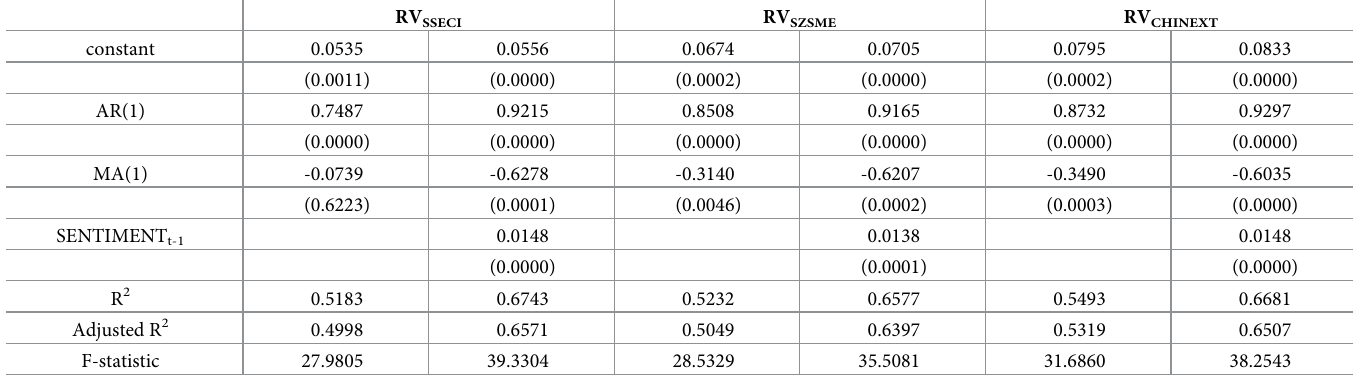
the prediction performance. RMSE refers to the prediction errors. Theil’s inequality coefficient provides a measure of how well the predicted values compares to the observed values. The smaller the RMSE and Theil’s inequality coefficient are, the better the model performs. As shown in Table 9, investor sentiment which is constructed with INR, SMT, TURN and SVI (noted as SENTIMENT in Table 9) helps ARMA(1,1) achieve the smallest RMSE and Theil’s inequality coefficient. Investor attention also improves the prediction accuracy, but it performs Table 7. Estimated parameters of ARMA(1,1) with and without investor sentiment